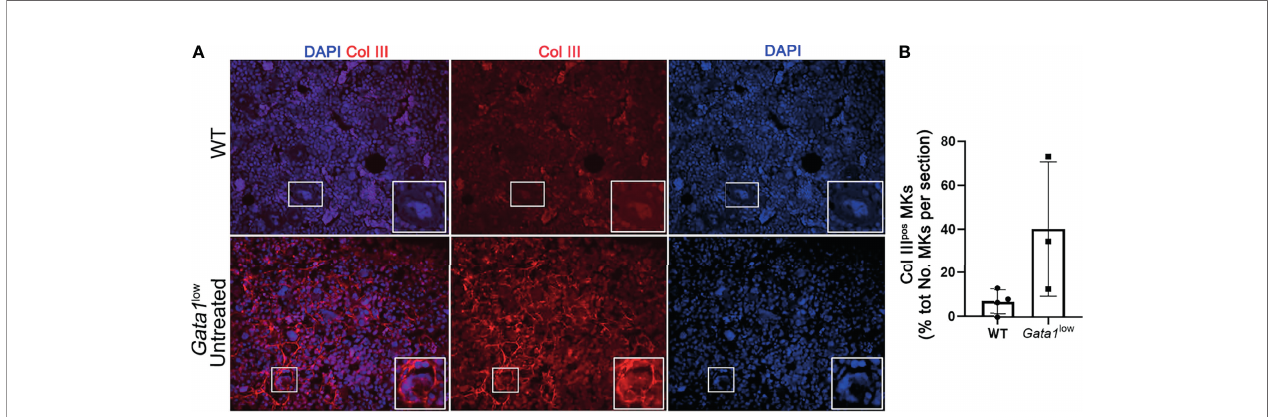
FIGURE 8 | The bone marrow from Gata1 low mice contains great numbers of megakaryocytes that express Collagen III. (A) Representative immuno fl uorescence staining with an anti-Col III (TRITCH-red) antibody showing that the MKs from Gata1 low mice express higher levels of Col III than those from their WT littermates. Megakaryocytes were recognized on the basis of their morphology (size and morphology of the nucleus). Magni fi cation ×400. The white boxes indicate representative MKs shown at greater magni fi cation on the right bottom side of each panel. (B) Percent of MKs positive for CollIII (Col III pos MKs) over the total numbers of MKs observed in BM sections from WT and Gata1 low littermates. Data are presented as Mean (± SD) and as frequency per individual mouse (dots) and were analyzed by One-way ANOVA. Each dot represents a single mouse. P < 0.05 was considered statistically signi fi